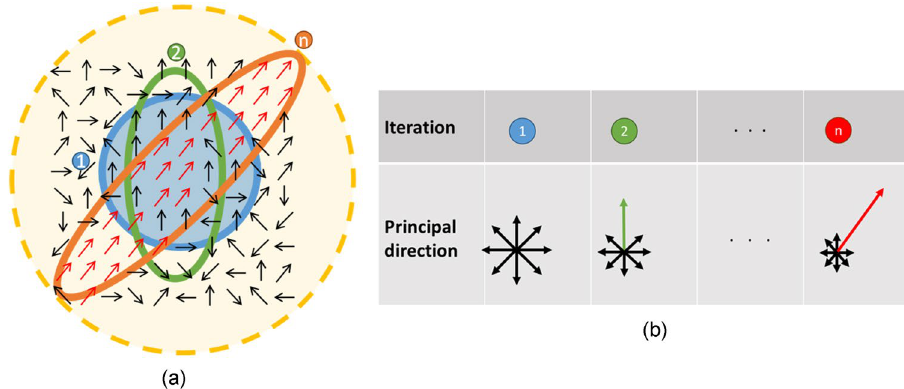
Figure 3. ( a ) Receptive field effective enlarged after a repetitive sequence of deform-and-rotate. ( b ) The th principal direction found for ( a ) upon convergence at n